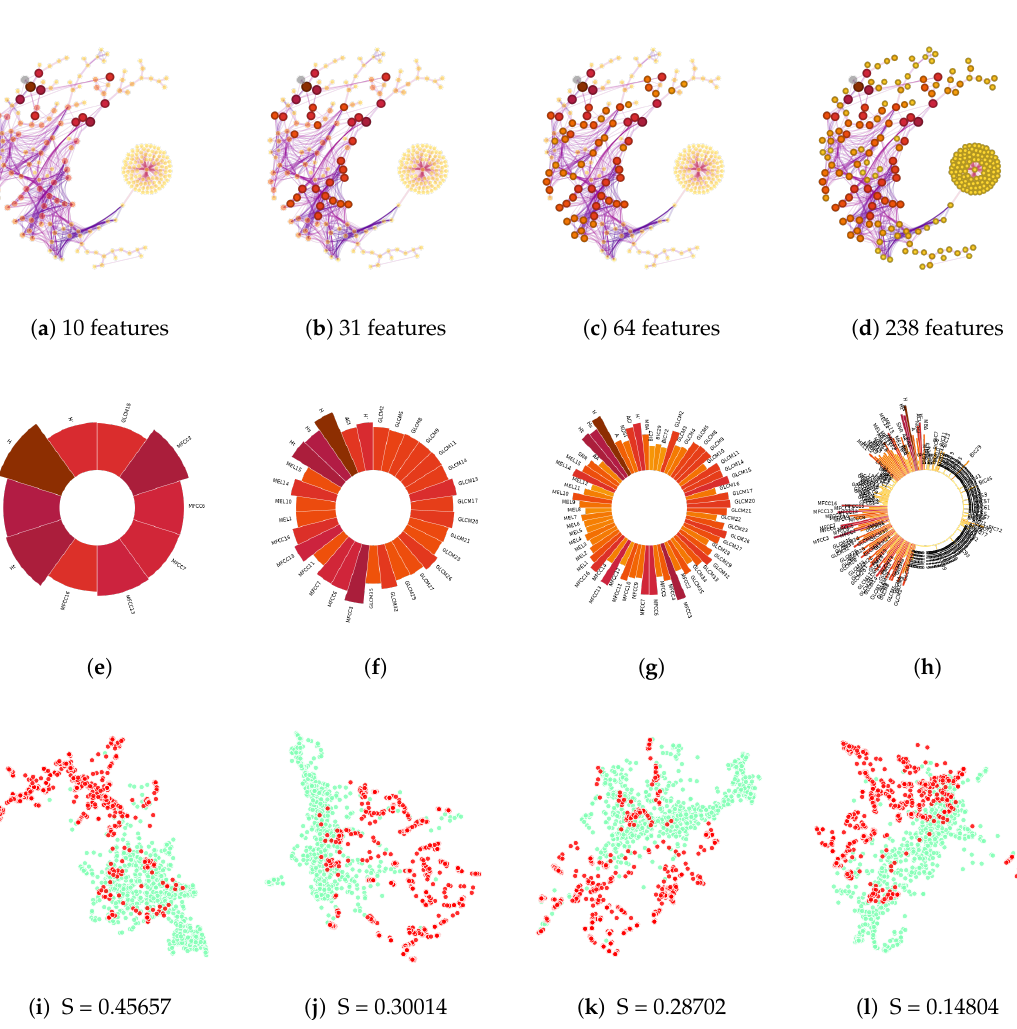
Figure 5. Soundscape ecology data for bird and insect classes, initially with 238 features. ( a – d ) Similarity MSTs displaying an increasingly larger set of features selected by ranked relevance (Pearson correlation), with high similarity graph edges. ( e – h ) Circular histograms of the selected features. ( i – l ) LSP projections (cosine dissimilarity) of the 1662 data points from the space of selected features on 2D and silhouette values. In the figure, a graph is related to the projection and to the circular histogram in the same